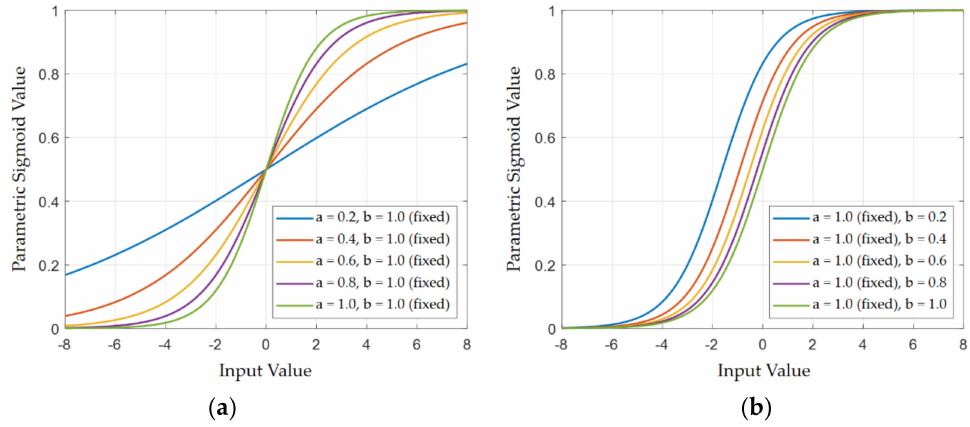
Figure 4. Shape of the parametric sigmoid ( a ) for different values of a and fixed b as 1, and ( b ) for different values of b and fixed a as 1. Note that both a and b are adaptively determined during the network learning process. When both a and b are 1, the parametric sigmoid is degenerated into the original